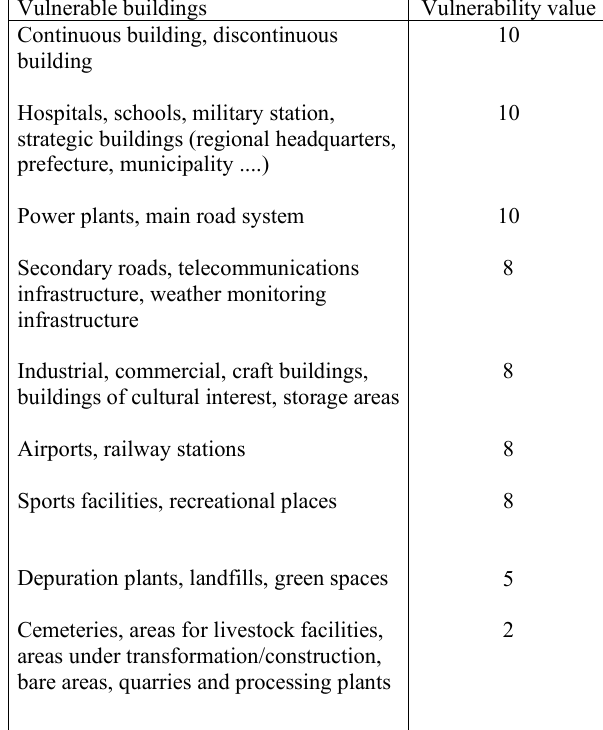
Table 2 . Assignment of scores to be adopted for the vulnerability of buildings based on the Italian Civil Protection Operations Manual